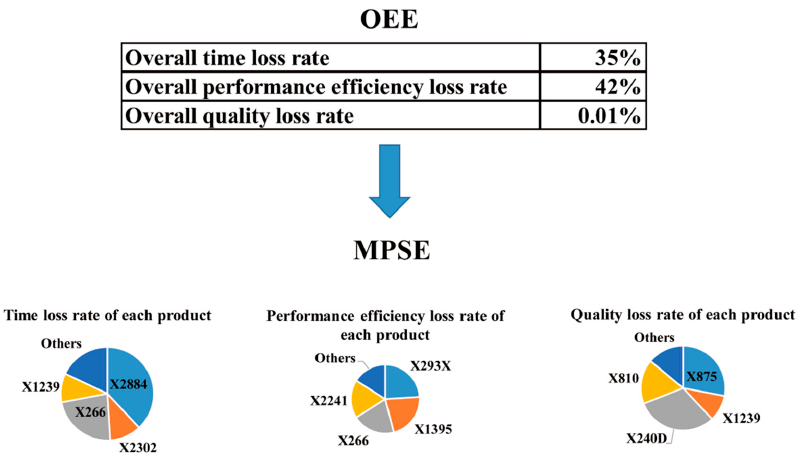
Figure 8. The changes of the adequacy after using MPSE.